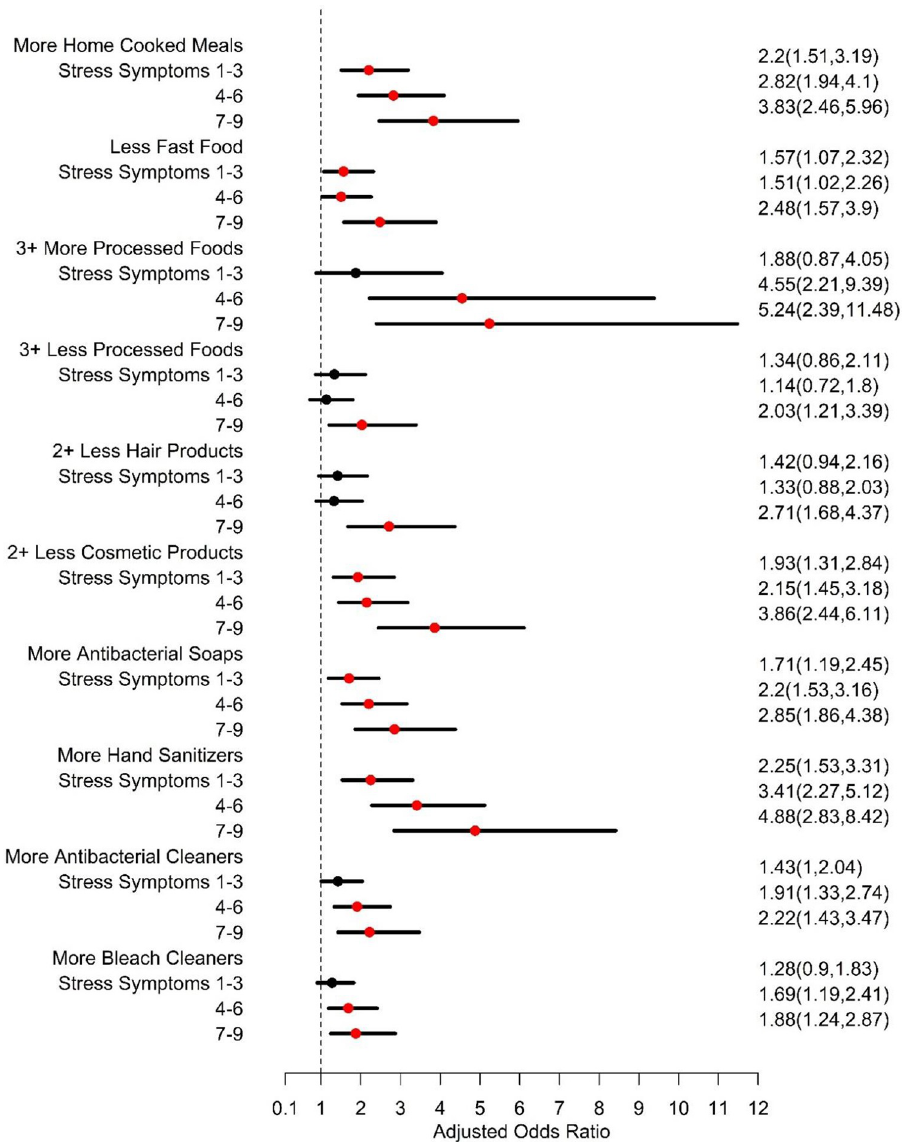
marital status, number of people in the household, whether any household member tested COVID-19 positive, and whether the cohort was New Hampshire (NH). �� Statistically significant results indicated by red